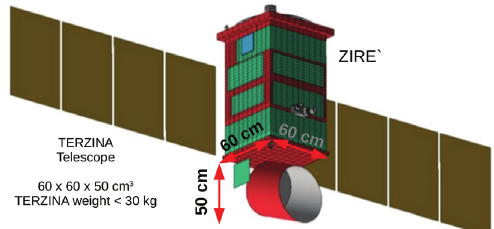
Figure 1: The NUSES satellite containing the Ziré appa- ratus at the top and the Terzina telescope at the bottom during the